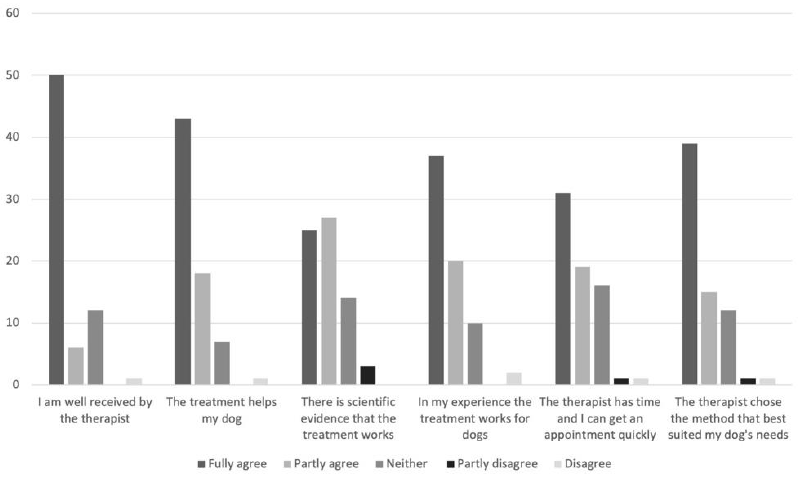
Figure 1. Responses by Swedish dog owners ( n = 69) to the question “If your dog has been treated with complementary and alternative veterinary medicine, why did you choose that therapist and/or method?”.